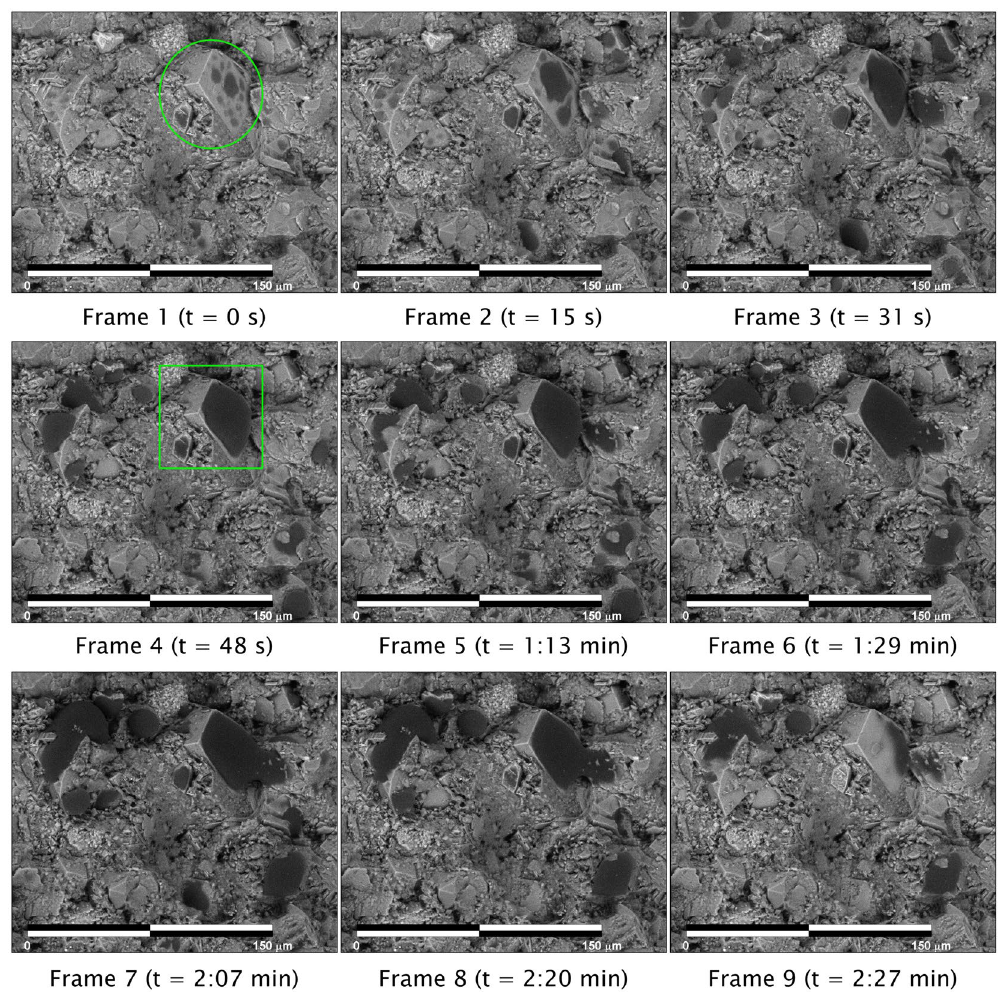
Figure 2. Time-lapse images (compiled over 2:27 minutes) of a condensation/evaporation experiment performed on a middle Bakken sample using the E-FESEM. Micro-droplets of distilled water can be seen forming on the large dolomite grain, annotated by the green circle (Frame 1). As the experiment progresses, the droplets coalesce into a larger micro-droplet (Frames 2–4) which can then be used for contact-angle measurement (green box in Frame 4). The micro-droplet in Frame 4 was chosen for this purpose because, later in the condensation process (Frames 5–6), pinning and the merging of the micro-droplet with a micro-droplet in an offset grain affects the contact-angle measurement. Evaporation occurs during Frames 8–9. The sample temperature was held at around 2.0 °C, and chamber pressure around ~700 Pa. The scale bar is 150 µ